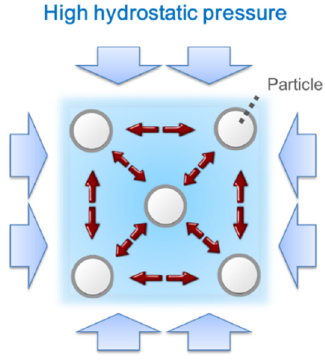
Figure 6. The repelling ‐ particles system under high hydrostatic pressure.